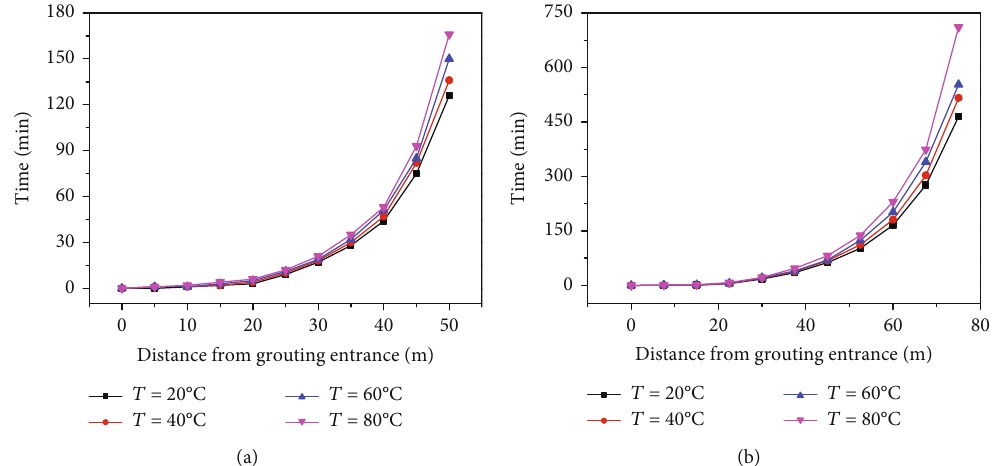
Figure 8: Time it takes for the grout to pass through di ff erent distances in the fracture with di ff erent lengths when temperature fi eld is ignored: (a) 50 m and (b)